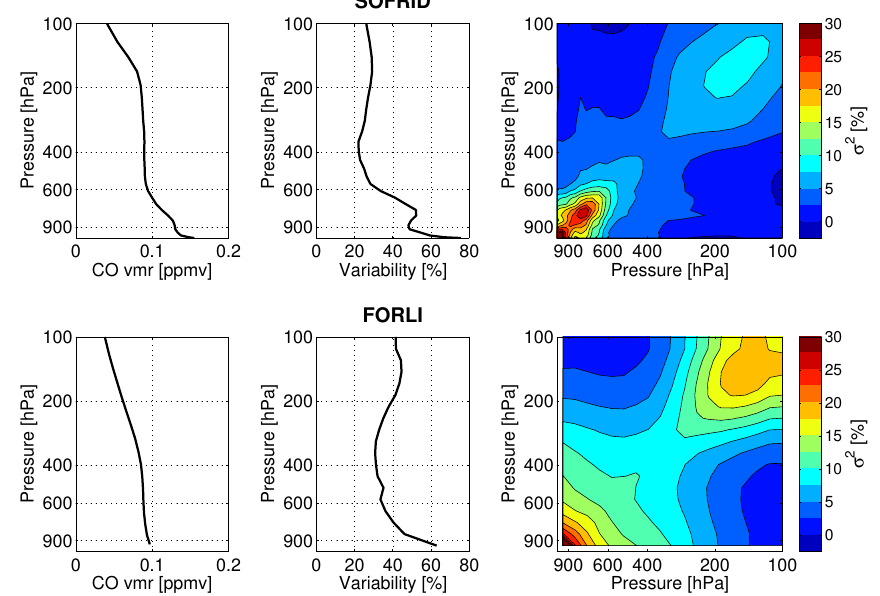
Fig. 1. For SOFRID (top panels) and FORLI (bottom panels): the a priori profile (left panel), the a priori variability (middle panel) and the a priori covariance matrix (right